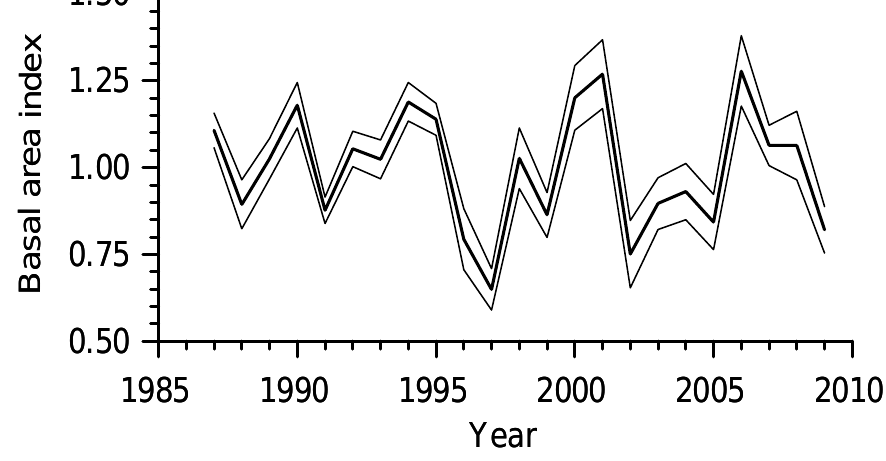
Figure 2. Basal area index (BAI) growth chronology of all 18 full-sib families of hybrid poplar ( P. × smithii ) combined (bold line) and the lower and upper limits of a 95% confidence interval of the mean (thin lines).